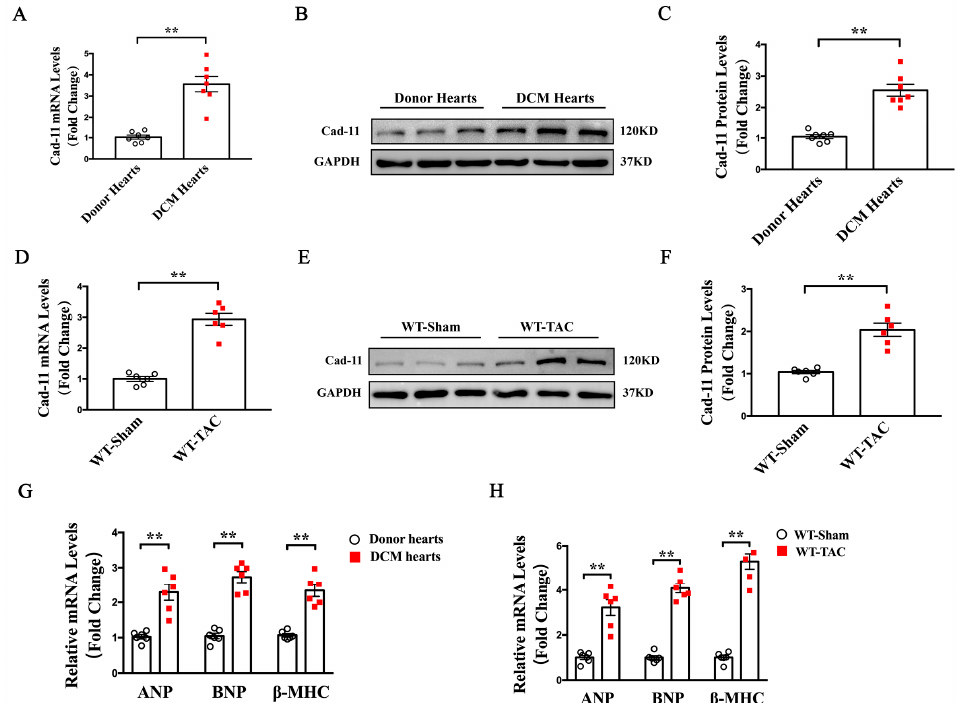
Figure 1. Increased Cad-11 expression was found in the left ventricles of heart from human heart failing patients and TAC-mice. ( A – C ) Representative mRNA and protein levels of Cad-11 in heart samples from normal donors and DCM patients. ( D – F ) Representative mRNA and protein levels of Cad-11 in the left ventricles of WT mice at 4 weeks after sham or TAC operation. ( G ) qRT-PCR analyses of ANP, BNP, and β -MHC mRNA levels in the left ventricles of normal donors and DCM patients ( n = 6). ( H ) qRT-PCR analyses of ANP, BNP, and β -MHC mRNA levels in the left ventricles of WT-Sham and WT-TAC mice. Data were presented as mean ± SEM. ** p < 0.01 vs. Donor’s heart or WT-Sham group.